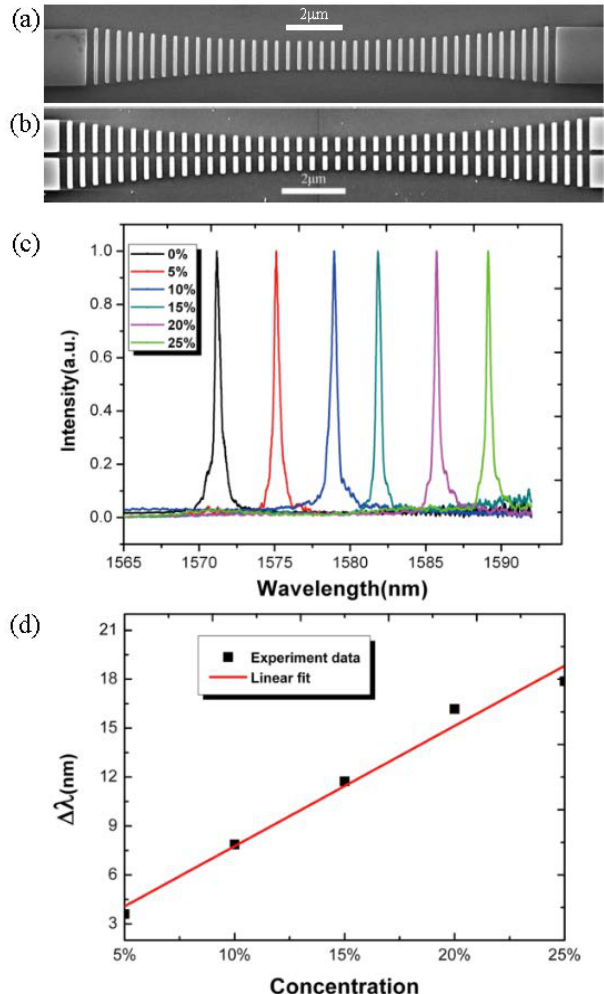
Figure 1: Images of the fabricated PhC cavity devices without (a) and with (b) slots. Measured transmission responses (c) and resonant wavelength shifts (d) of the slotted device covered under aqueous NaCl solutions with different concentrations. Adapted from Ref.